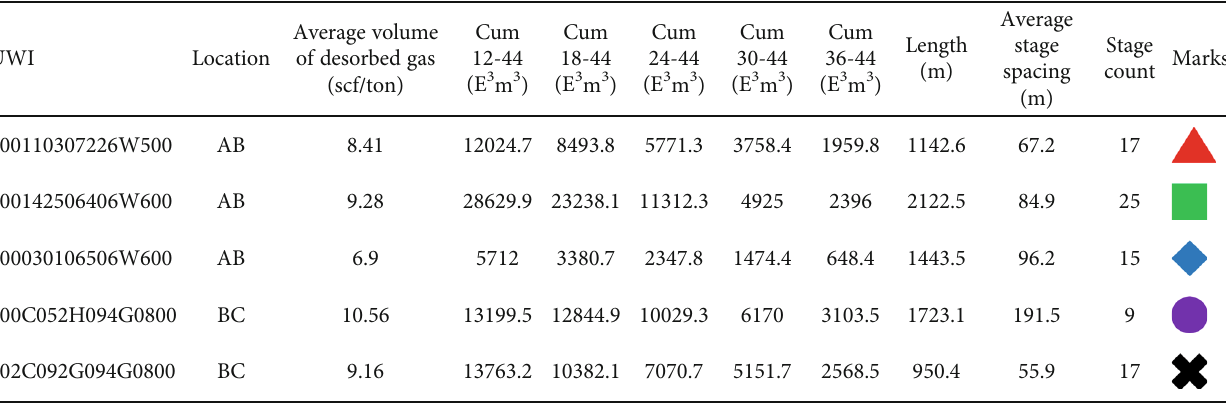
Table 4: Five wells compared between the log-based estimated desorbed gas volume and gas production history data. From cum 12-44 to cum 35-44 refers to the sum of gas production month. Length refers to the horizontal length used for gas production of well. This length was divided into stages as a given standard, and its average length represents the average stage spacing. AB: Alberta; BC: British Columbia; E 3 m 3 : thousand cubic meter.